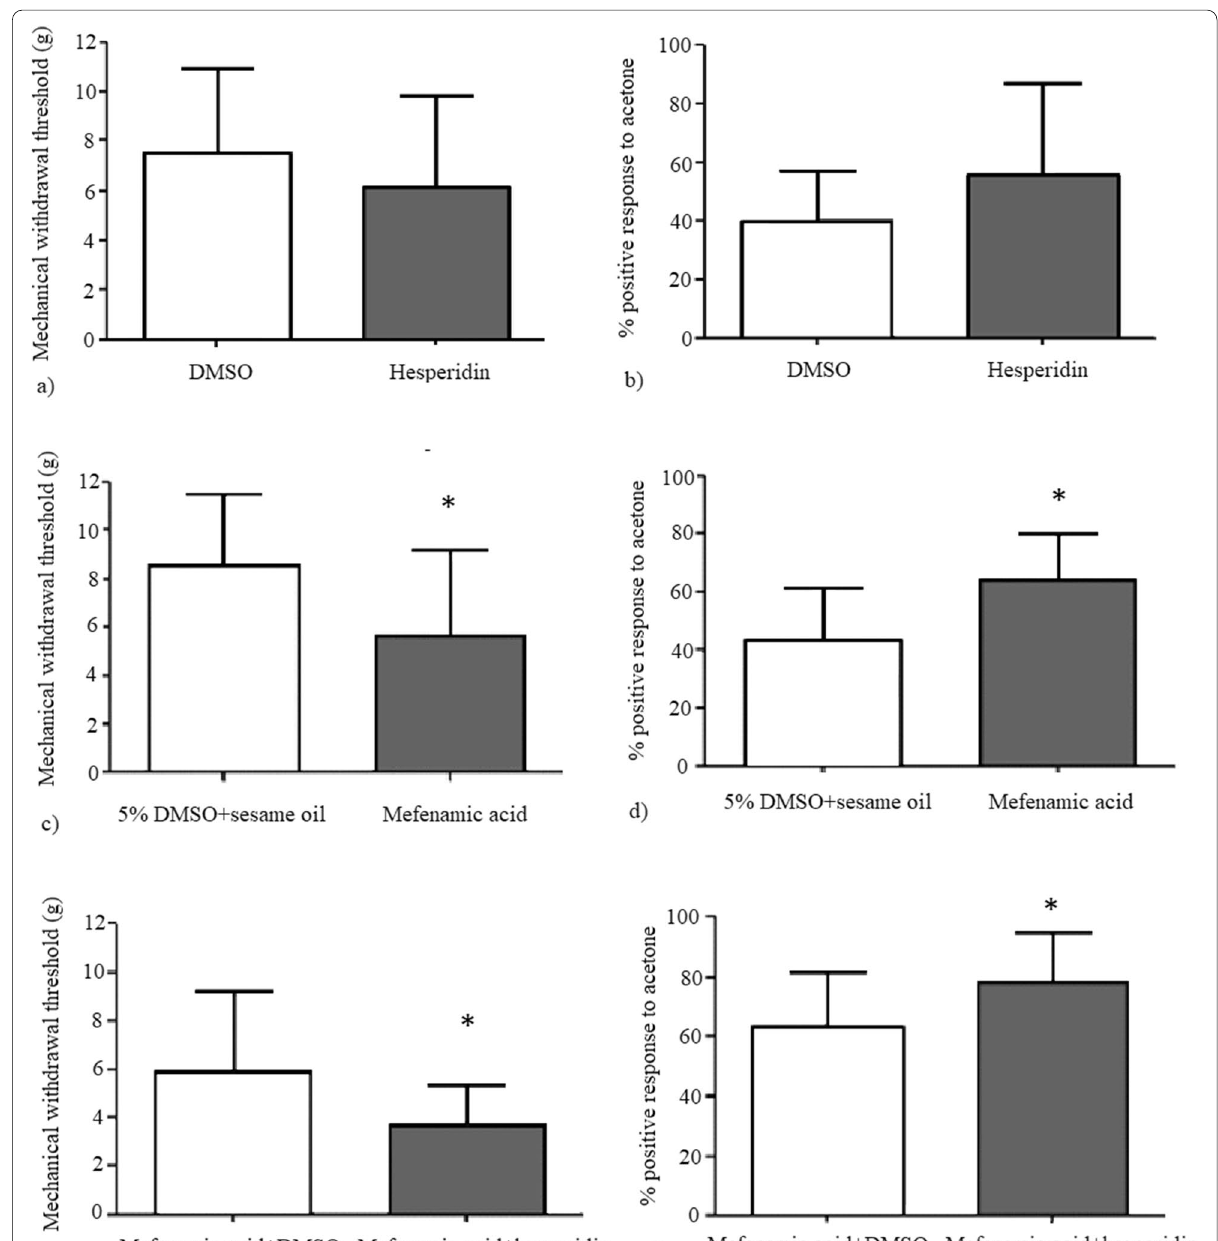
Fig. 5 No statistically significant difference was found between hesperidin and DMSO groups regarding a ) the mechanical withdrawal thresholds ( p 0.34) and b ) the percent positive response to acetone ( p = percent positive responses to acetone were higher (